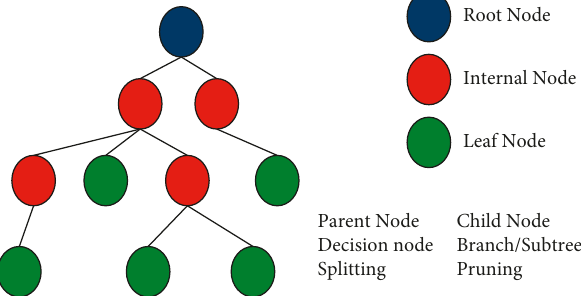
Figure 3: Illustration of the decision tree